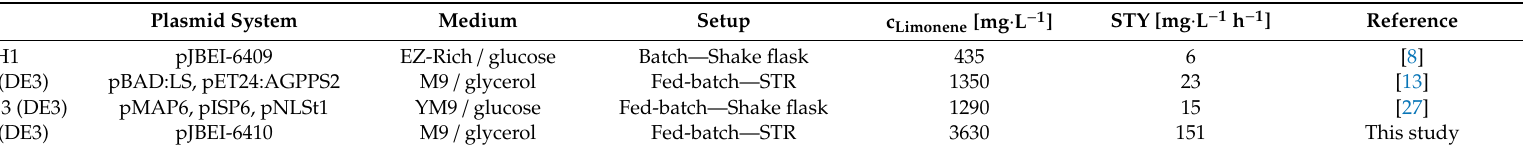
Table 1. Escherichia coli -based fermentation setups for the production of